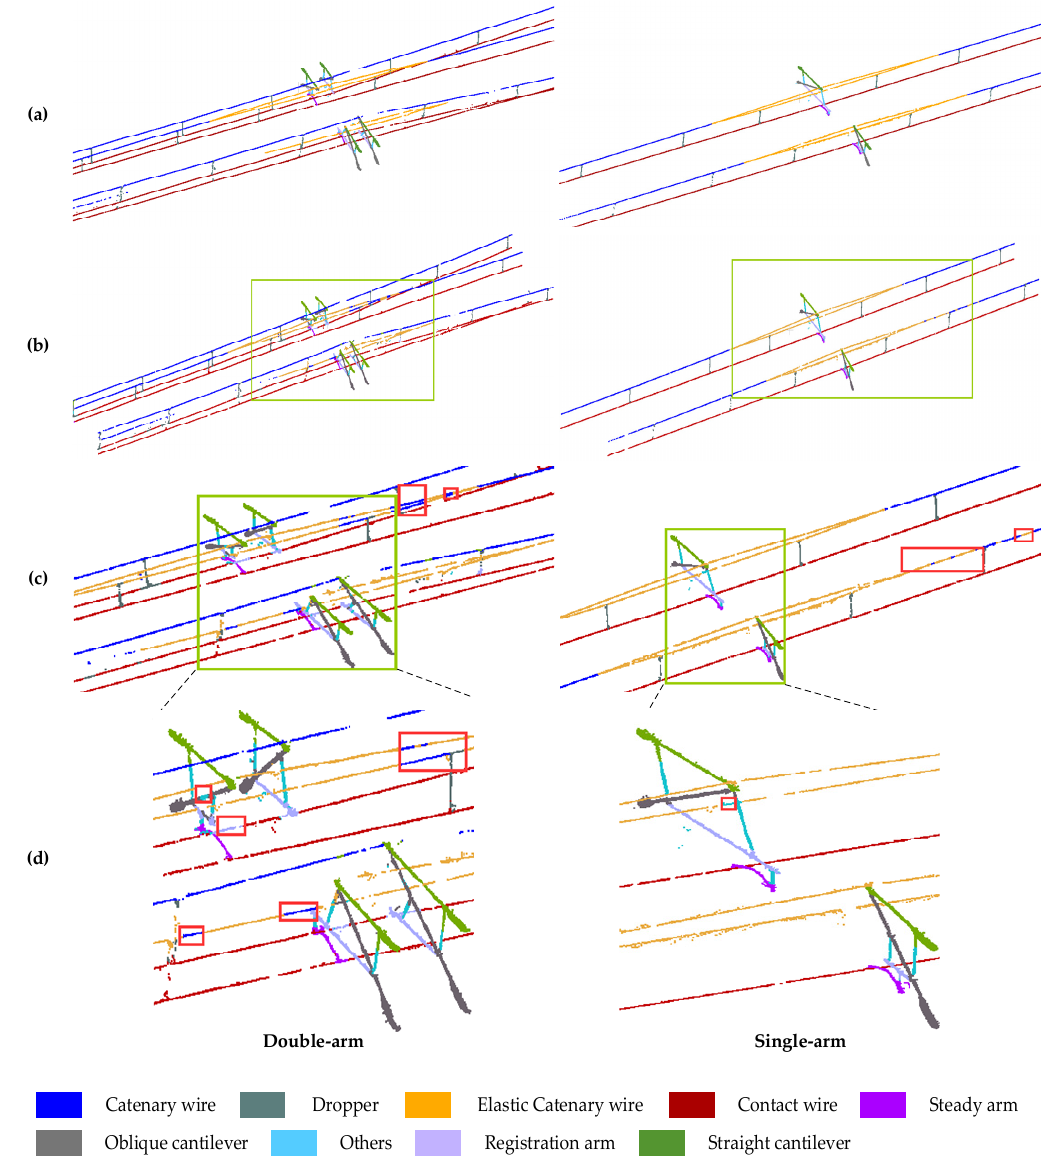
Figure 8. Prediction results of single-arm and double-arm. ( a ) is the true value, ( b ) is the semantic segmentation result of PMFR-Net, ( c ) is the content in the green box in ( b ), and the red box is the wrongly classified point cloud, ( d ) is the content in the green box in ( c ), and the red box is the wrongly classified point